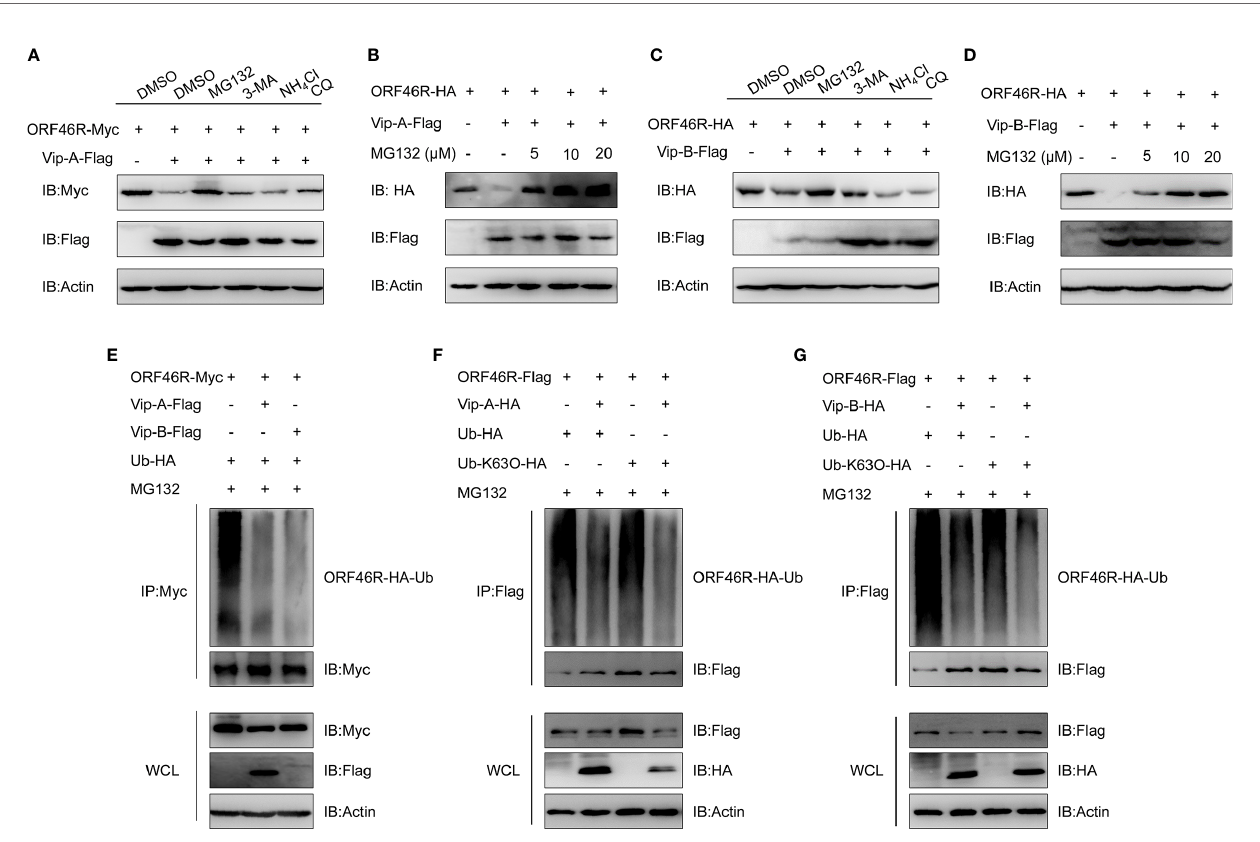
FIGURE 7 | Cg Viperin-A and Cg Viperin-B promote Ca HV ORF46R proteasomal degradation via decreasing K63-linked ubiquitination. (A, C) Effects of inhibitors on Cg Viperin-A (A) or Cg Viperin-B-mediated (C) destabilization of ORF46R. CAB cells were seeded in six-well overnight and transfected with the indicated expression vectors (2 m g/well). The cells were treated with the indicated inhibitors at 18 h post-transfection and harvested for western blot analysis with the anti-Flag and anti- b - actin Abs. (B, D) ORF46R degradation induced by Cg Viperin-A (B) or Cg Viperin-B (D) was rescued by MG132 in a dose-dependent manner. CAB cells were transfected with the indicated expression vectors (2 m g/well) and treated with DMSO or MG132 (5, 10, or 20 m M) for 6 h at 18 h post-transfection. Then, the WCL were subjected to western blot analysis with the indicated Abs. (E) Cg Viperin-A and Cg Viperin-B decreased the ubiquitination of ORF46R. CAB cells were seeded in 10 cm 2 dishes and transfected with 5 m g ORF46R-Myc, 4 m g Cg Viperin-A-Flag or Cg Viperin-B-Flag, and 1 m g HA-Ub and were treated with DMSO or MG132 for 6 h at 18 h post-transfection. After IP with anti-Myc-af fi nity gels, the immunoprecipitates and WCL were analyzed by western blot analysis with the indicated Abs. (F, G) Cg Viperin-A (F) and Cg Viperin-B (G) decreased the K63-linked ubiquitination of ORF46R. CAB cells were seeded in 10 cm 2 dishes were co-transfected with the indicated expression vectors (5 m g ORF46R-Flag, 4 m g Cg Viperin-A-HA, or Cg Viperin-B-HA) and 1 m g HA-Ub or Ub-K63O-HA, and were treated with MG132